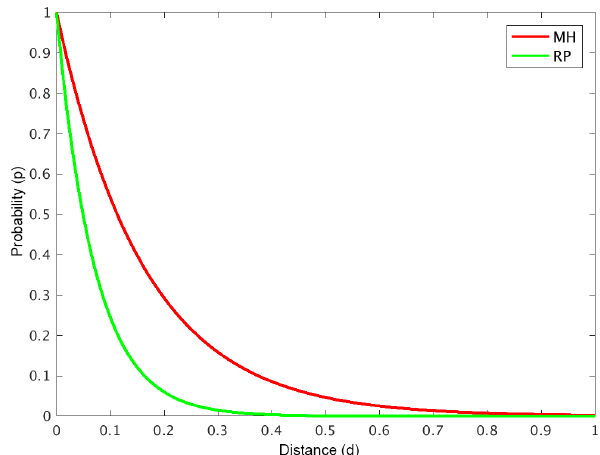
Figure 4. An example of the exponential transformation: the scaled distances to the probability ( d → p